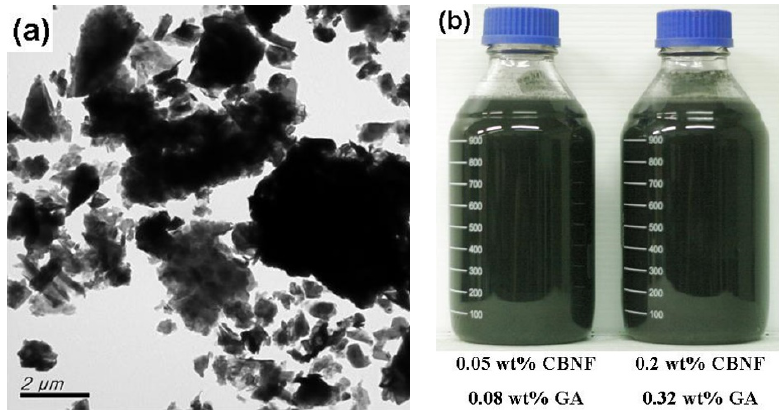
Figure 2. Experimental samples: ( a ) TEM images of CBNMs; ( b ) actual photograph of CBNFs.